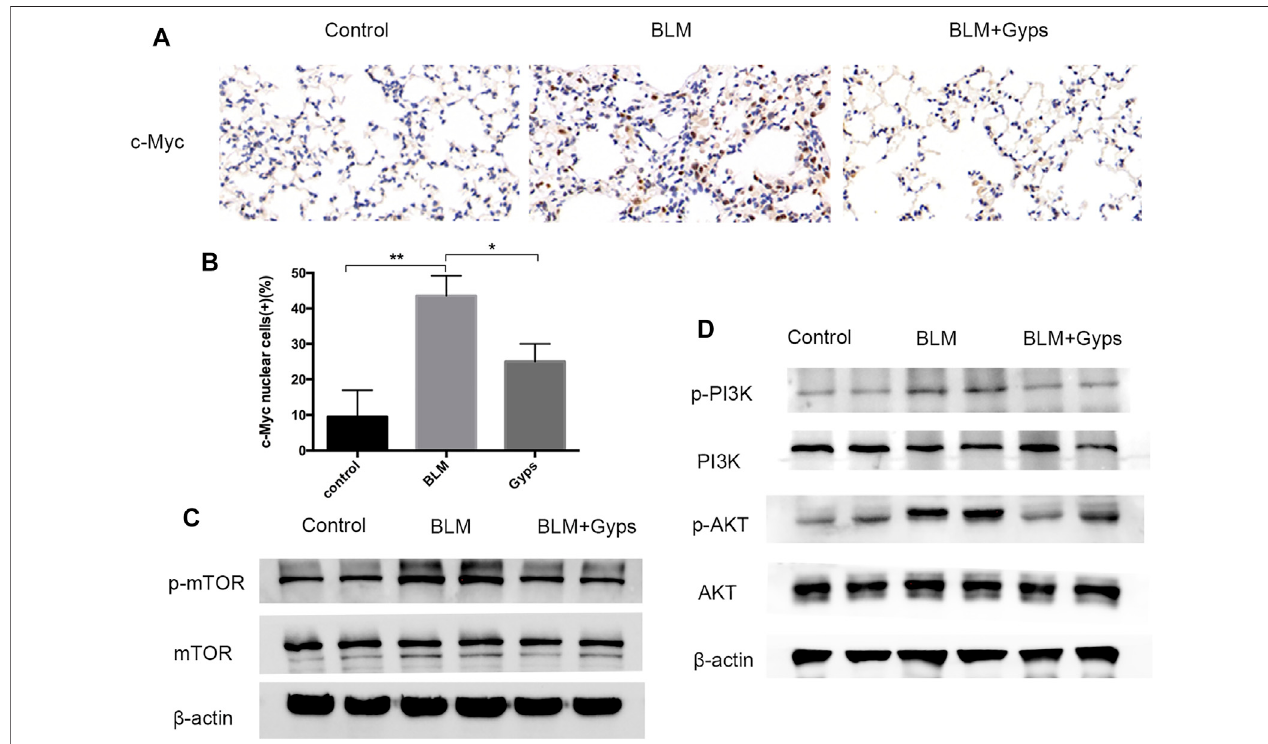
FIGURE 5 | Expressions of c-Myc, p-mTOR, mTOR, p-PI3K, PI3K, p-AKT, and AKT in the mouse model. (A) c-Myc Immunohistochemical staining (400 × ). (B) Quantitation of the data presented in panel (A) . (C, D) Protein expression levels of p-mTOR, mTOR, p-PI3K, PI3K, p-AKT, and AKT as detected by Western blotting. Gyps (cid:1) gypenosides, BLM (cid:1) bleomycin. *** p < 0.001, ** p < 0.01, compared with control; * p < 0.05 compared with